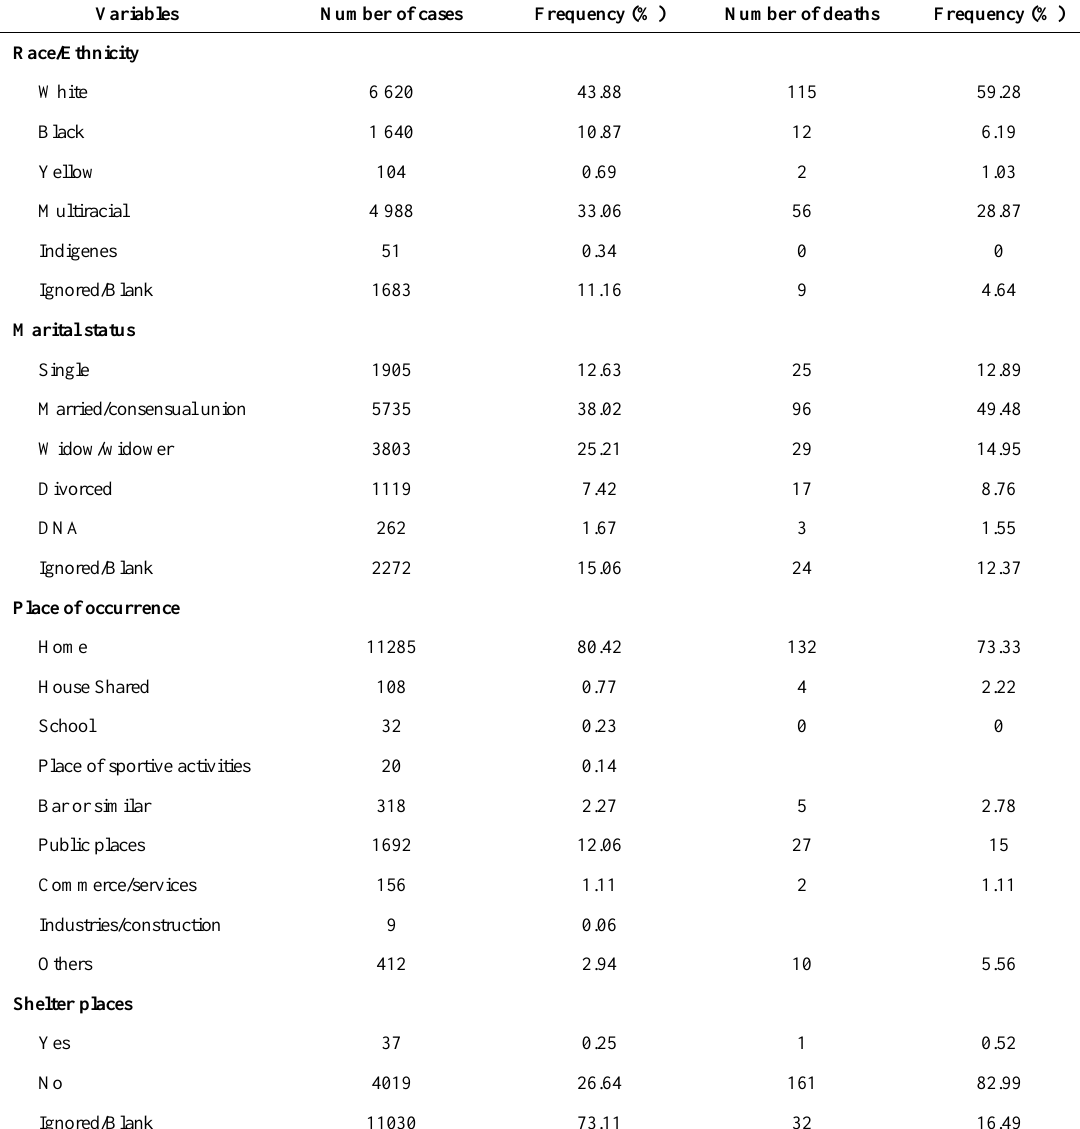
Table 2. Distribution of violence against the elderly cases according to the race, marital status, place of occurrence, and if it occurred in a shelter. Data from SINAM between 2007 and